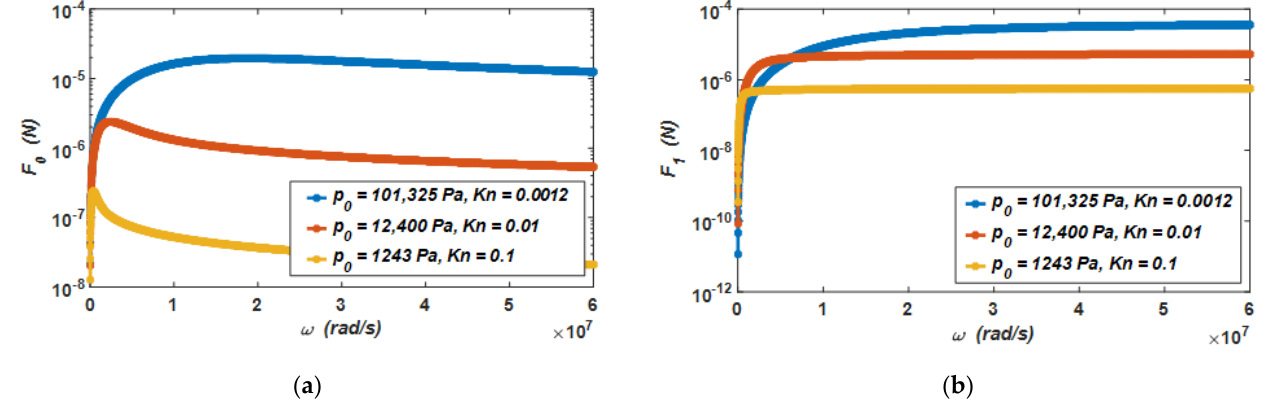
Figure 4. ( a ) The relationship between the viscous damping force and the vibration frequency of the micro-accelerometer, and ( b ) the relationship between the elastic damping force and the vibration frequency of the micro-accelerometer when the air pressure drops from the standard atmospheric pressure to 1243 Pa.